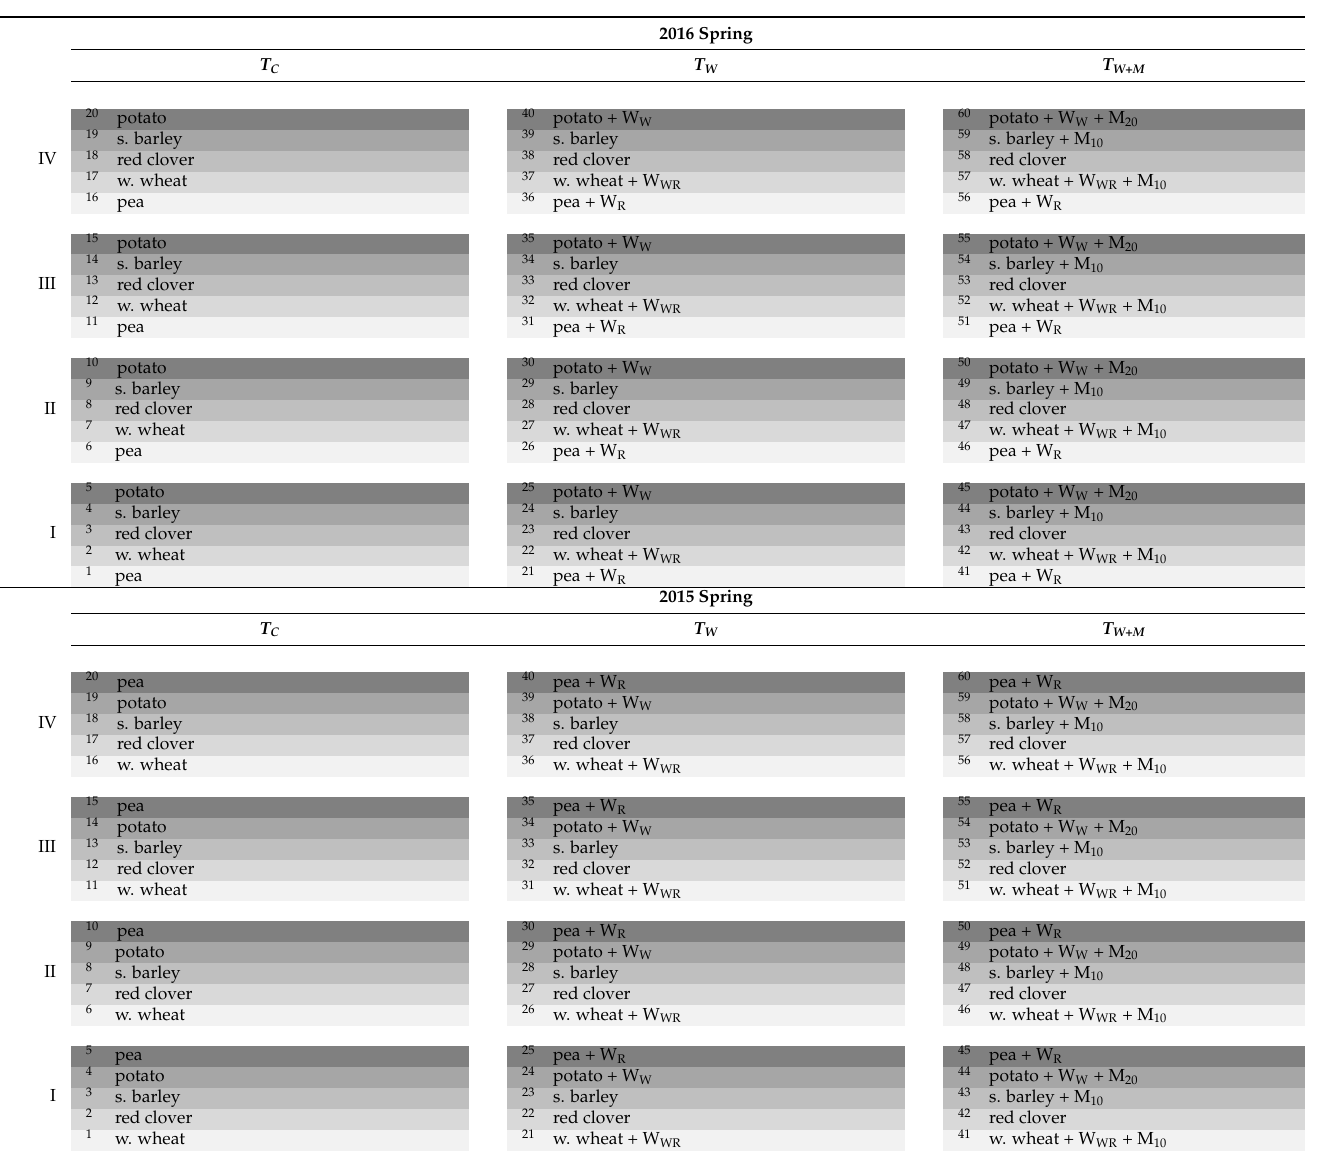
Table 2. The schema of the field experiment, which reflects the cropping sequence in spring of 2015 and